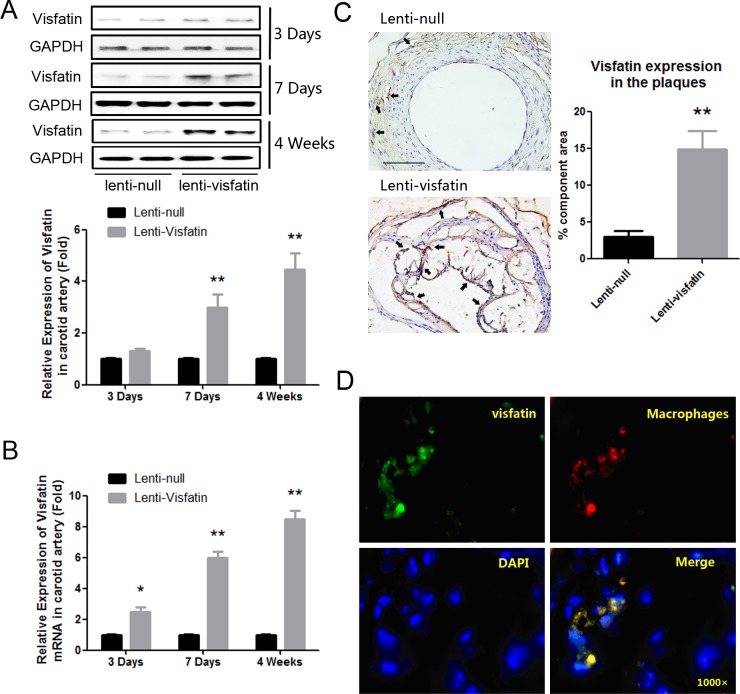
Expression of Visfatin in the lenti-null group and lenti-visfatin group.A, Western blot analysis was used to detect the visfatin expression in the represent samples of carotid plaques from the lenti-null group and lenti-visfatin group respectively after lentivirus transduction for 3 days, 7 days and 4 weeks. B, Real-time PCR was used to detect the visfatin mRNA expression in the carotid plaques of the lenti-null group and lenti-visfatin group. C, Immunochemical stainings of visfatin in the plaques in the lenti-null group and lenti-visfatin group after lentivirus transduction for 4 weeks were shown. The positive staining areas are indicated in brown. D, The co-localization of visfatin (green) with macrophages (red), according to immunofluorescence staining, is shown. Scale bar: 100μm. Arrows are indicative of representative visfatin staining positively regions. ** P<0.01 versus the lenti-null group. Data shown are the means ± SEM.